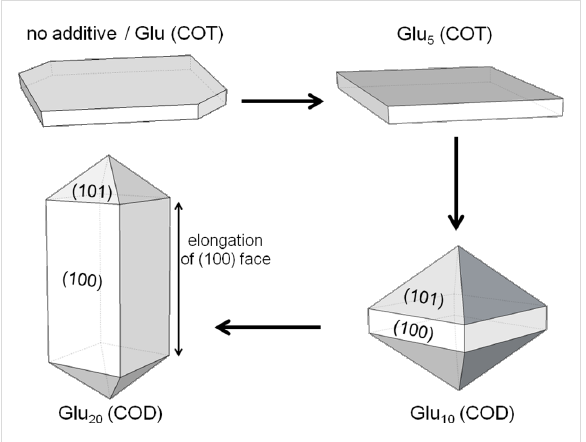
Figure 2: Schematic representation of the evolution of the morphology of calcium oxalate crystals prepared in the presence of oligo(L- glutamic acid)s of different lengths, ranging from the monomer (Glu) to the eicosamer (Glu 20 ). COD: calcium oxalate dihydrate; COT: calcium oxalate trihydrate. Reprinted with permission from [38]. Copyright 2010 American Chemical